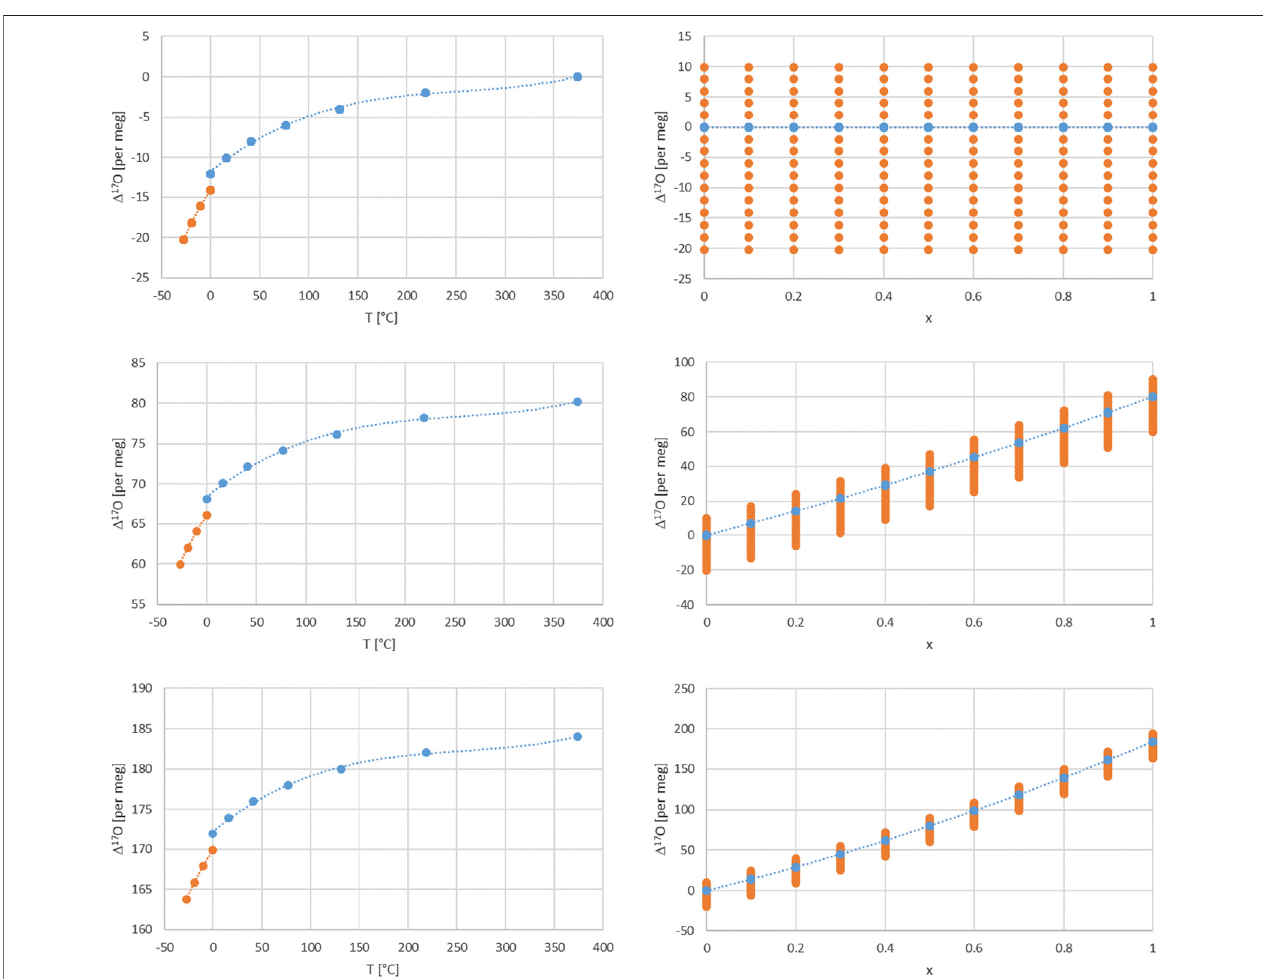
FIGURE 4 | Dependence of Δ 17 O on temperature for a turbulence factor n of 0.6, x (cid:1) 1 and for different relative humidity values of 1, 0.5, and 0 (upper, middle and lowerleftpanels). Orangedashed lineforfractionation valuesbetweenice andvapor(Ellehojetal.,2013)and bluedashed lineforfractionationvaluesbetweenliquidand vapor water phase (Horita and Wesolowski, 1994). Dependence of Δ 17 O on the balance factor x for a turbulence factor n of 0.6 for different relative humidity values of 1, 0.5, and 0 (upper, middle and lower right panels). The dots correspond to δ 18 O values from − 20 to 10 per mil in steps of 2.